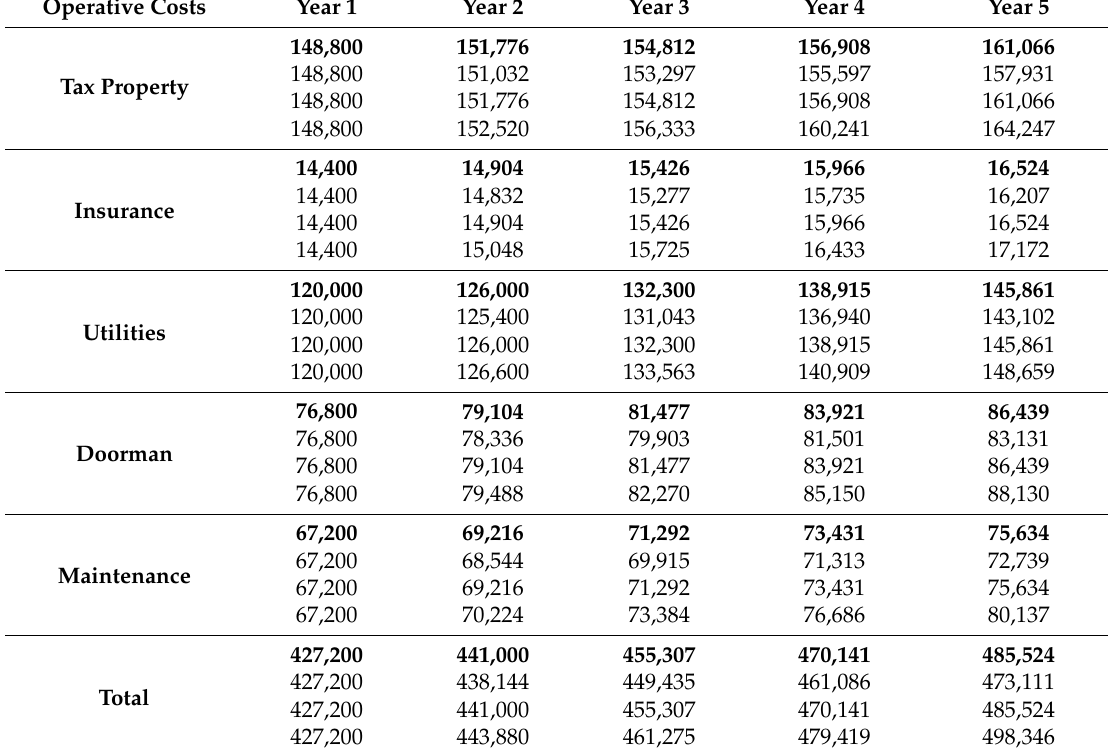
Table 5. Calculation of annual amounts of each operative